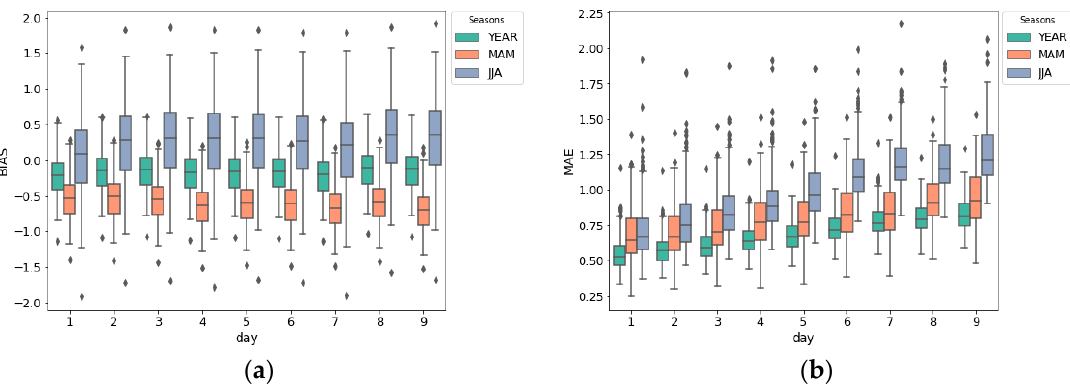
Figure 9. BIAS ( a ) and MAE (mean absolute error) ( b ) evaluated from daily differences of values of potential evapotranspiration calculated from forecast data and real measured data for year (YEAR), spring (MAM—March, April, May) and summer season (JJA—June, July, August) from the 1st to 9th day of the forecast in the year 2017.